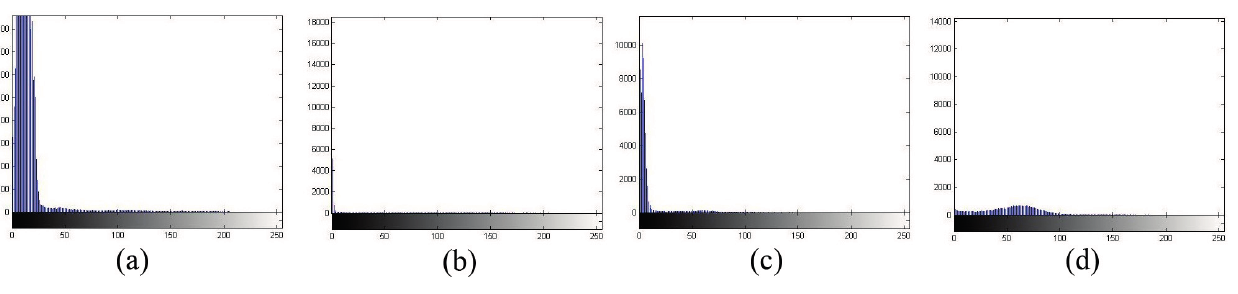
Figure 6. C component in the CMYK color space of four images in Figure 5.